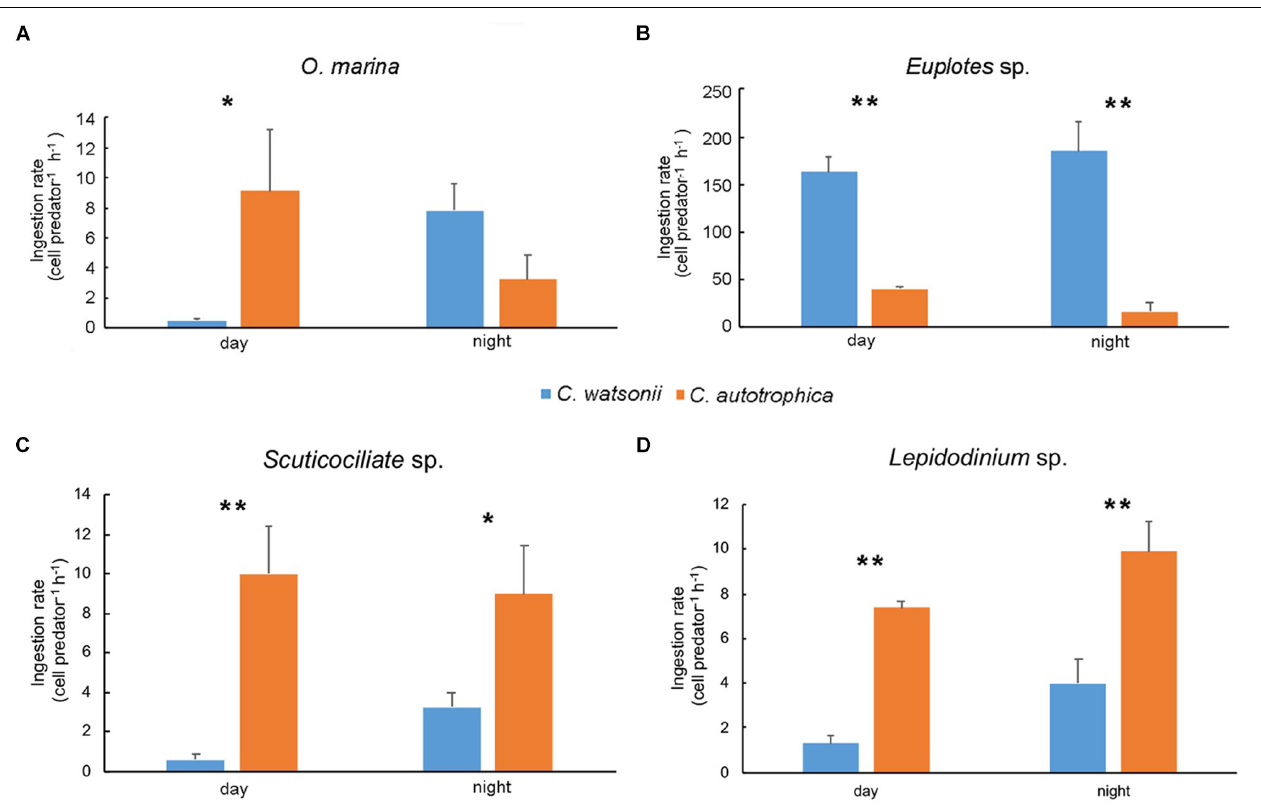
FIGURE 2 | Ingestion rate of Oxyrrhis marina (A) , Euplotes sp. (B) , Scuticociliate sp. (C) and Lepidodinium sp. (D) during daytime and nighttime. Values denote the mean ± standard error based on triplicates. Asterisks represent significant differences between ingestion rate on two prey (Student’s t -test, *, p <0.05, **, p